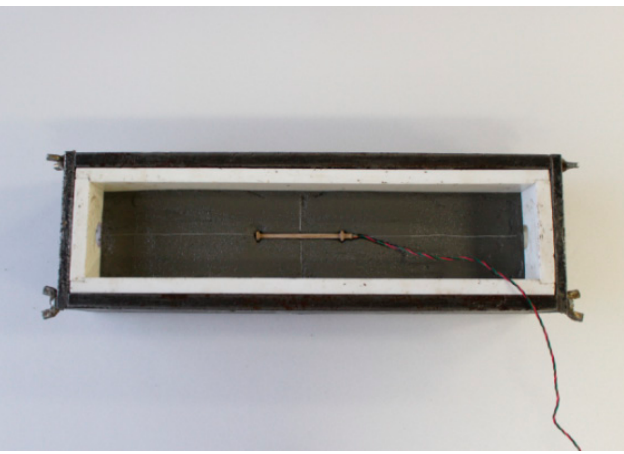
Figure 7. Test setup for measuring drying shrinkage.